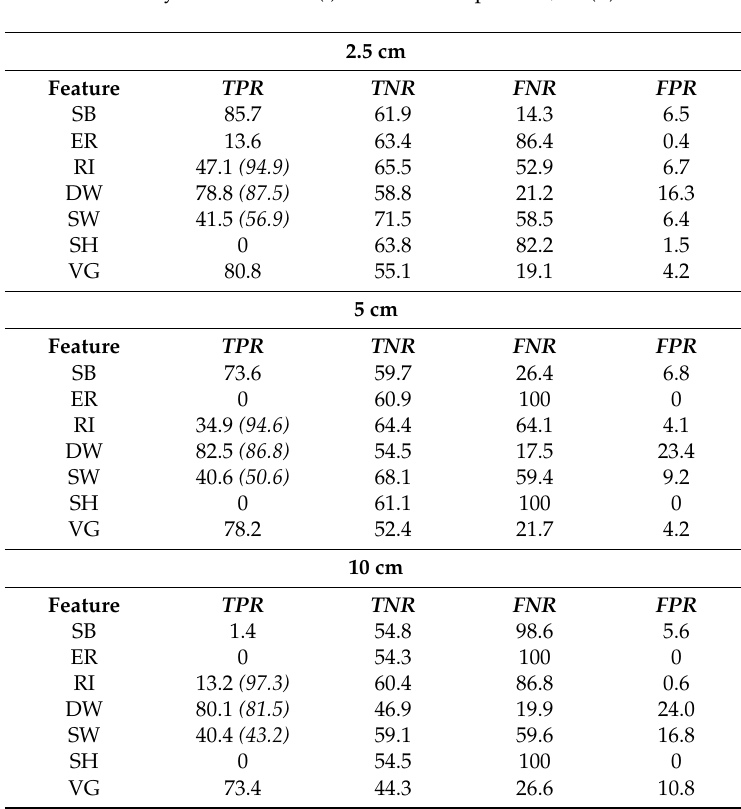
Table 5. Results obtained for each of the hydromorphological features identified per